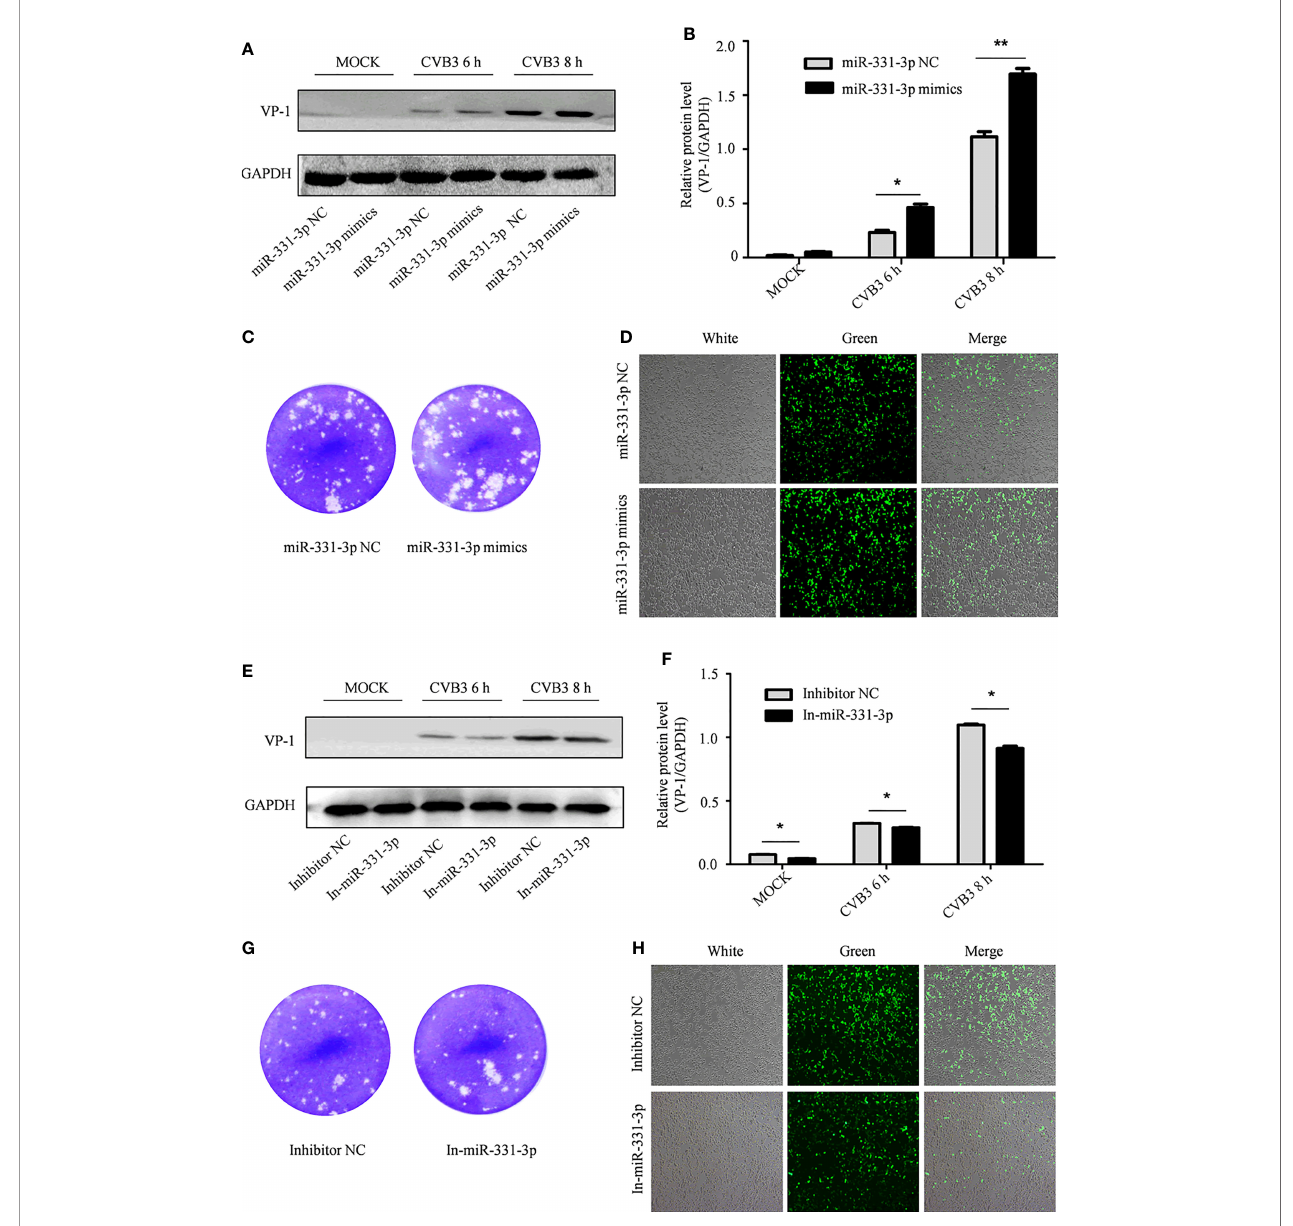
FIGURE 4 | The effect of miR-331-3p on the replication and proliferation of CVB3. (A, E) After transfection with miR-331-3p mimics/inhibitor for 36 h, cells were infected with CVB3 for 6 or 8 h, and total protein was extracted, and the effect of miR-331-3p on CVB3 replication was investigated by Western blot. (B, C, F, G) HeLa cells were infected with CVB3 36 h after transfection with miR-331-3p mimics/inhibitor. The viral supernatant after 6 h of infection was collected and used to infect HeLa cells for 1 h. The cells were solidi fi ed with low melting point agarose for 2 hours and fi xed with 75% glacial acetic acid for 48 hours. (D, H) 293T cells co-transfected with CVB3-eGFP and miR-331-3p mimics/inhibitor were observed by fl uorescence microscopy. *p < 0.05, **p <